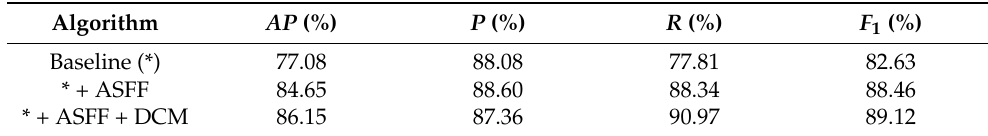
Figure 10. Detection results of three algorithms in four SAR scenes. The cyan rectangles refer to the ground truth. The green and red rectangles denote the detected targets and false alarms, respectively. For a more intuitive comparison of the differences between the two algorithms, a yellow marker is drawn on the detection results. ( a ) Baseline (*), ( b ) * + ASFF, ( c ) ADN: * + ASFF + DCM. Table 3. Effectiveness of different